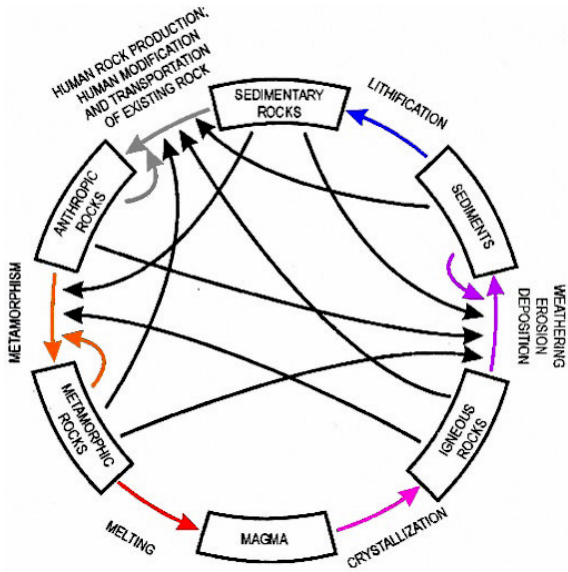
Figure 2. J. R. Underwood Jr.’s suggested impressionistic dia- gramming of the Earth’s Rock Cycle, including Anthropic Rocks. Blocks represent materials, arrows represent processes. (Credit: JRU. Modified from L. Don Leet and Sheldon Judson, Physical Geology, NY, Prentice Hall, Inc., 1954:49. Diagram drafted by Michael L. Hackney and colorized by Joseph J.